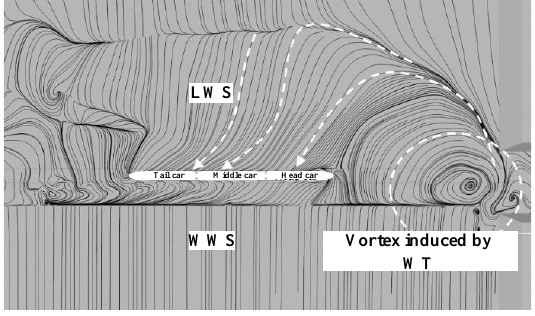
Figure 10. Top view of streamlines at a height 0.5 h.